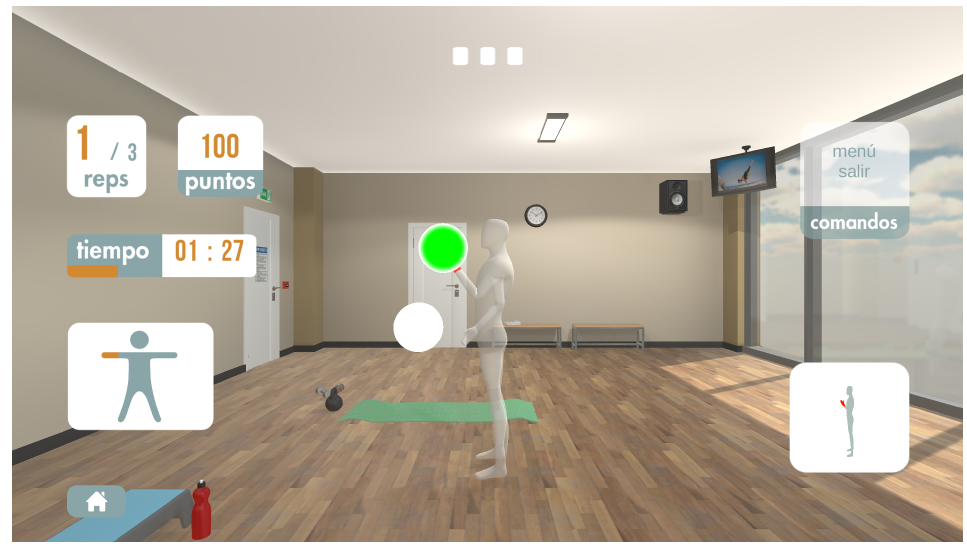
Figure 7. Left elbow flexion